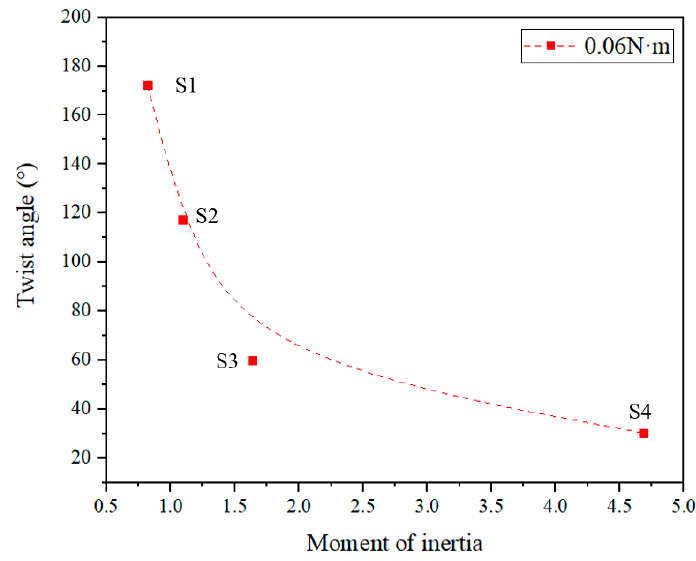
Figure 15. The relationship between the twist angle and the moment of inertia of SMAMSs.